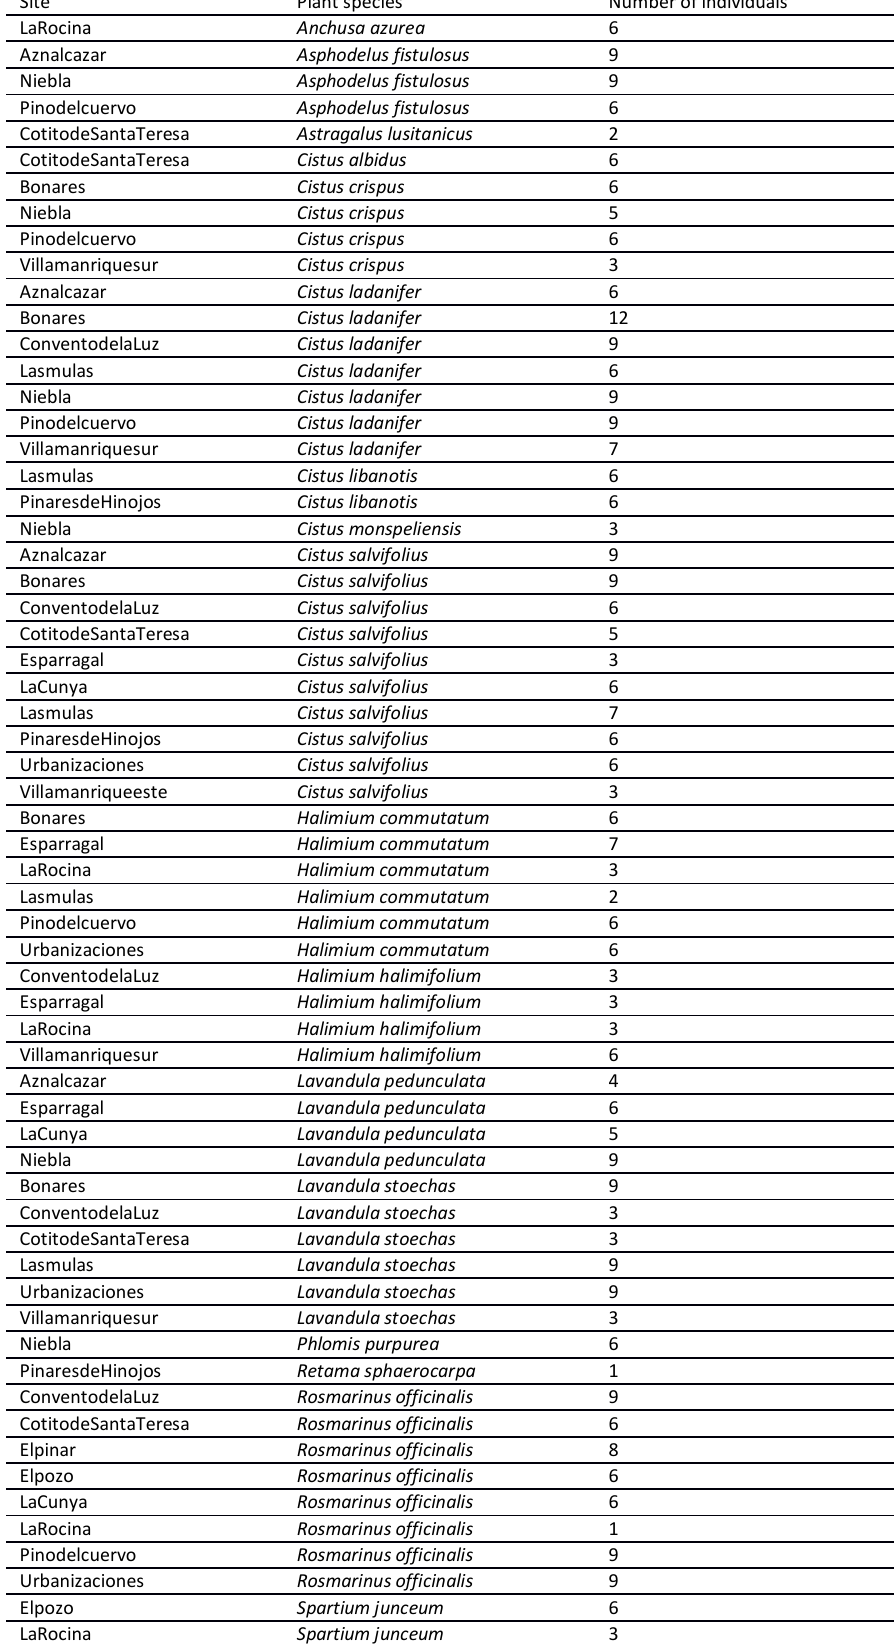
Table S2. Number of individuals per plant species sampled at each site to assess reproductive success.